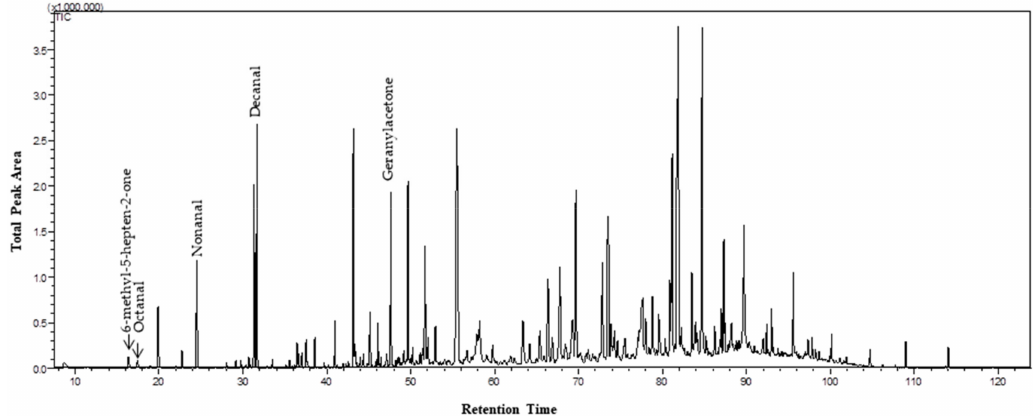
Figure 1. Total ion chromatogram showing the five peaks of volatile organic compounds selected as quality markers, detected as a function of retention